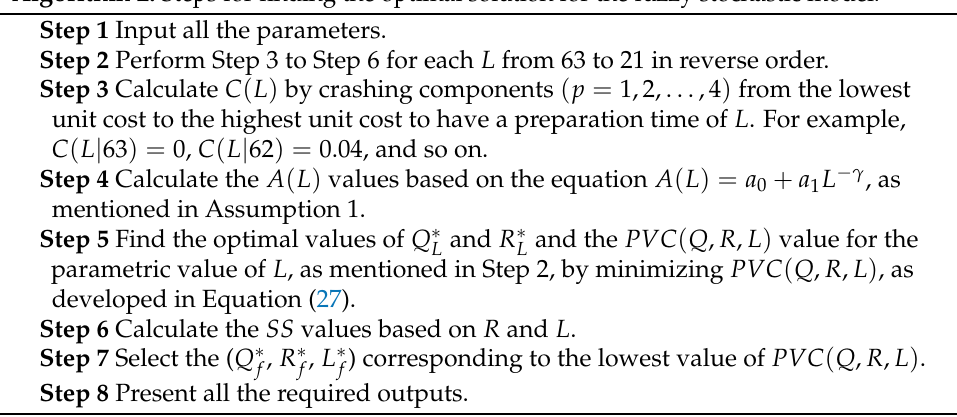
Algorithm 2: Steps for finding the optimal solution for the fuzzy stochastic model.